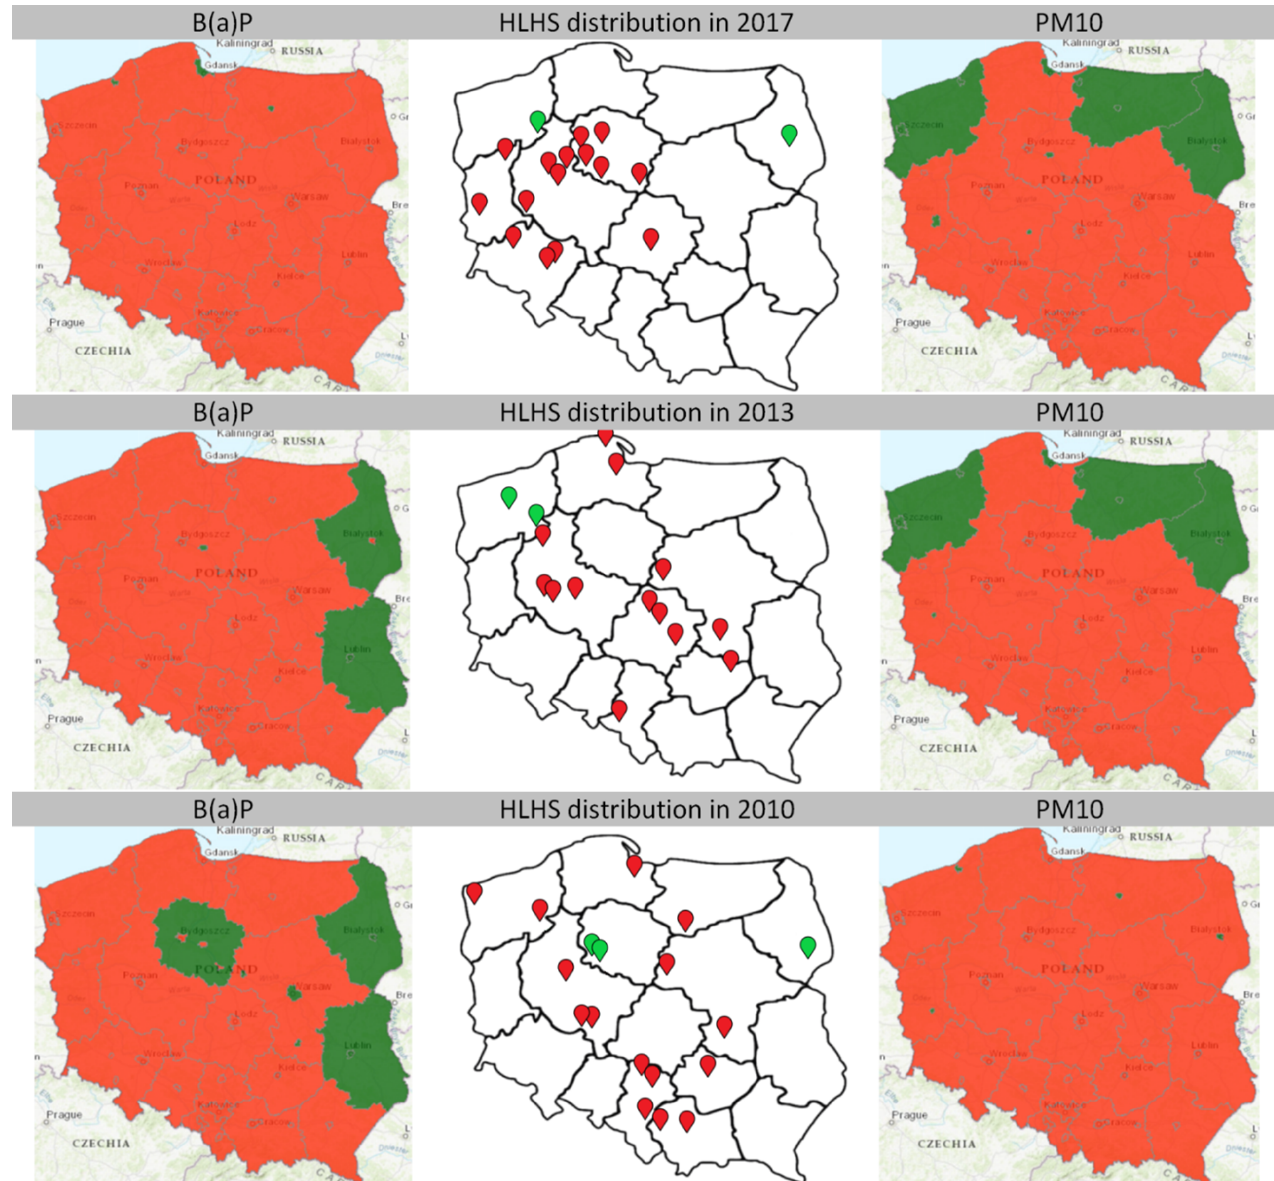
Figure 5. Levels of air pollution (B(a)P on the left and PM10 on the right) and territorial distribution of hypoplastic left heart syndrome cases in years 2017, 2013 and 2010. The red area corresponds to exceeding the permissible levels, in the green area the concentration of the measured factor is normal. In the middle, the distribution of all hypoplastic left heart syndrome cases in a given year is marked—the red dots correspond to the cases in the areas where both factors were above the norm and the green ones—where the concentration of one of the factors was normal. B(a)P—benzo(a)pyrene, HLHS—hypoplastic left heart syndrome.